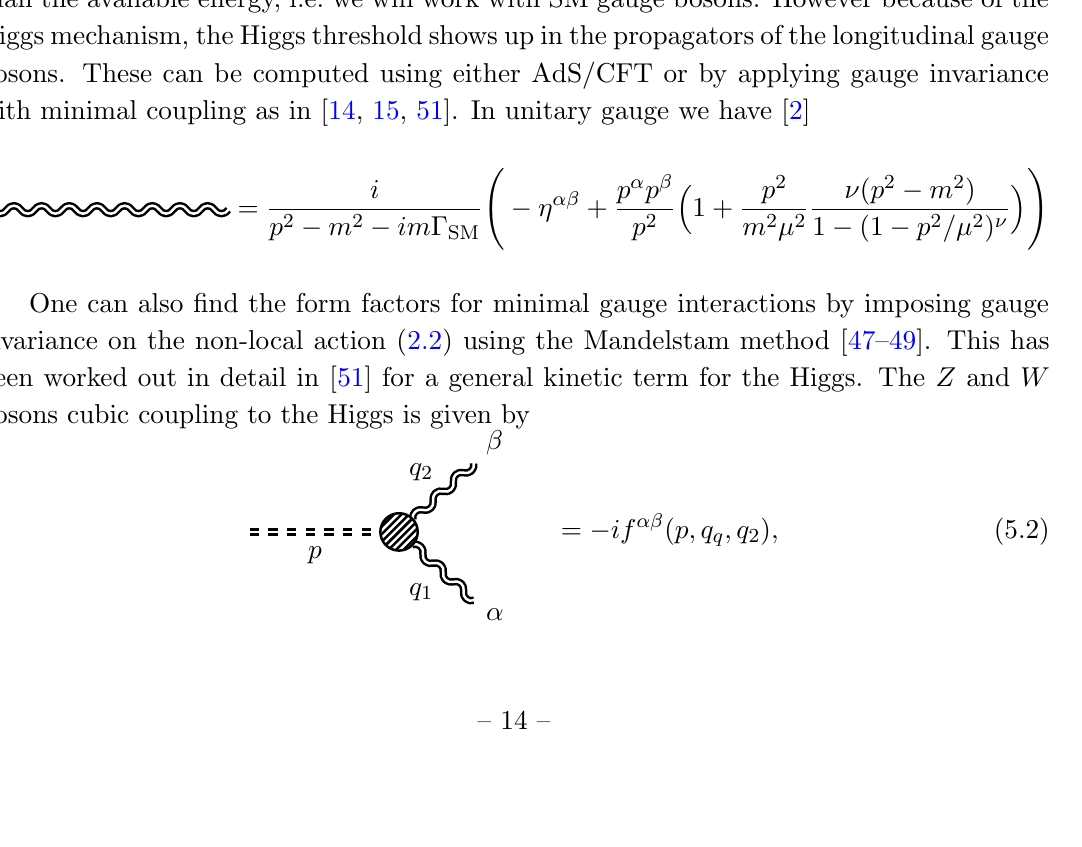
Figure 6. The QCH propagator used in the